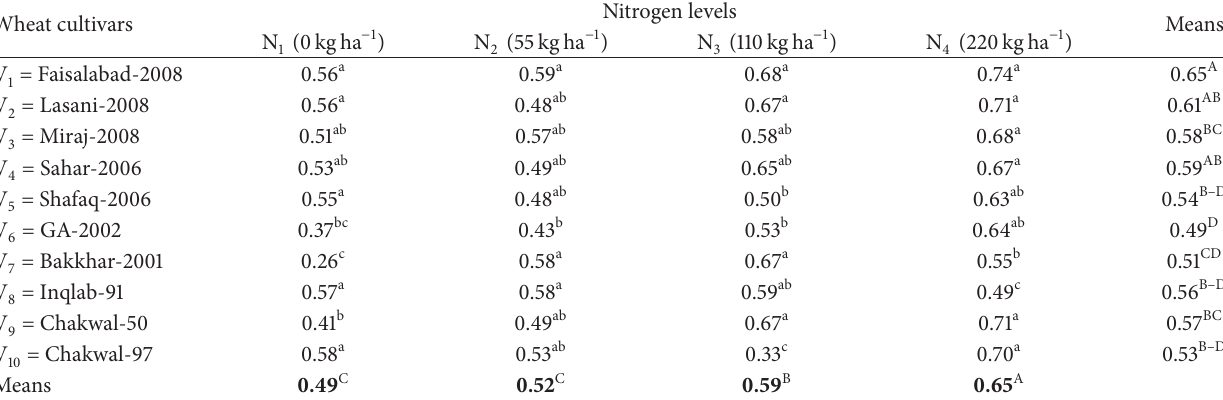
Table 5: Interactive effect of nitrogen levels in wheat cultivars for NDVI score at maturity stage for the year 2008-09. Wheat cultivars